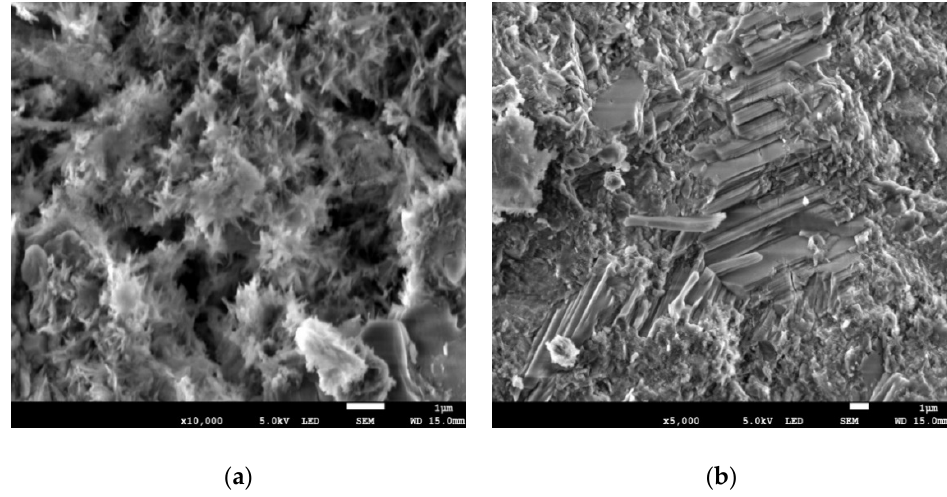
Figure 5. Scanning electron microscope (SEM) images of the samples taken from the cover layer of the concrete structure: ( a ) × 10,000; ( b ) × 5000.